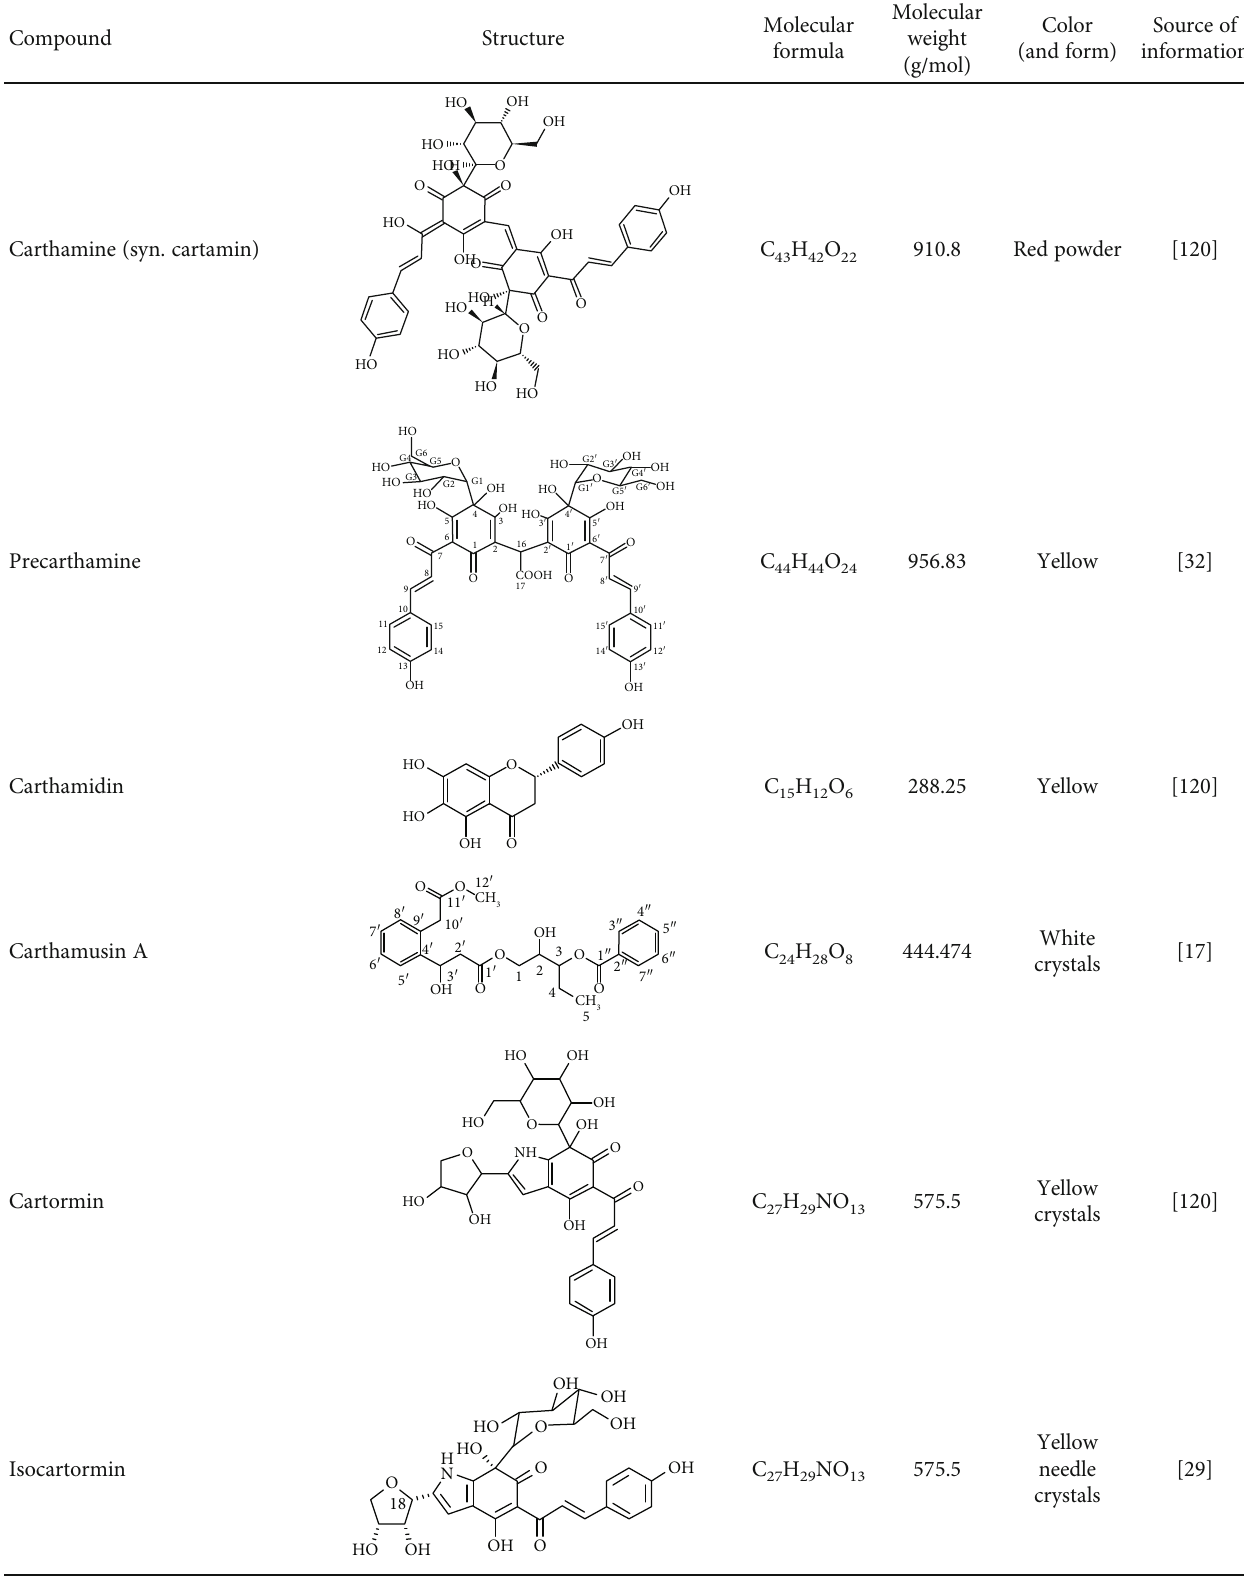
Table 1: The main components of the sa ffl ower fl ower